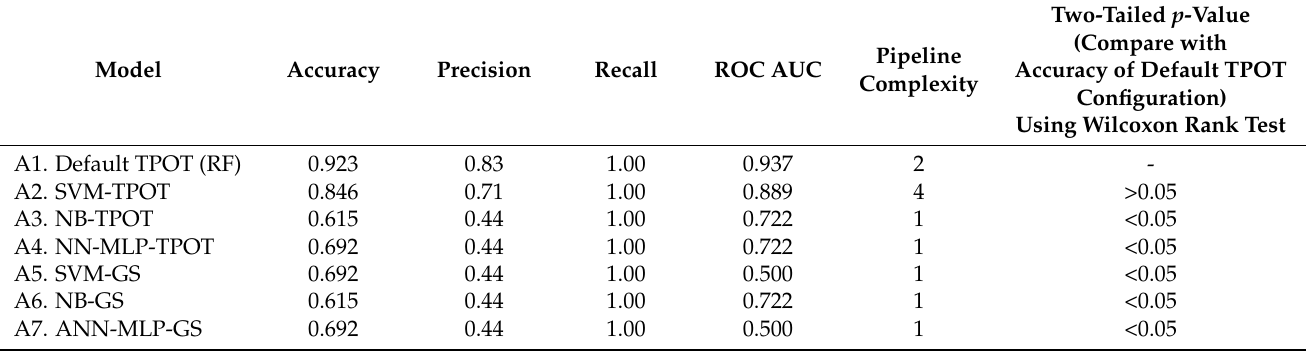
Two-Tailed p -Value (Compare with Pipeline Accuracy of Default TPOT Complexity Configuration) Using Wilcoxon Rank